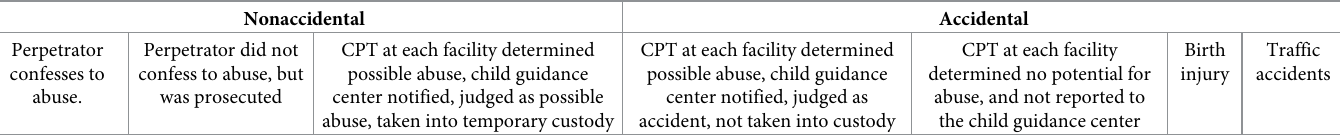
Table 1. Definition of “nonaccidental” and